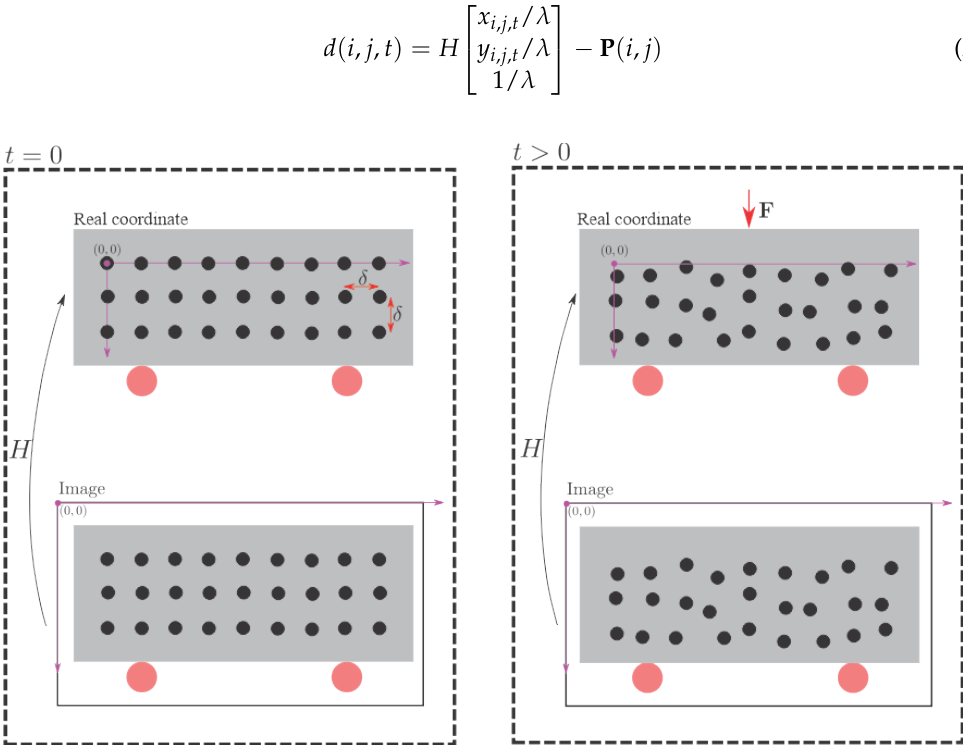
Figure 2. Proposed methodology for calculating displacement in